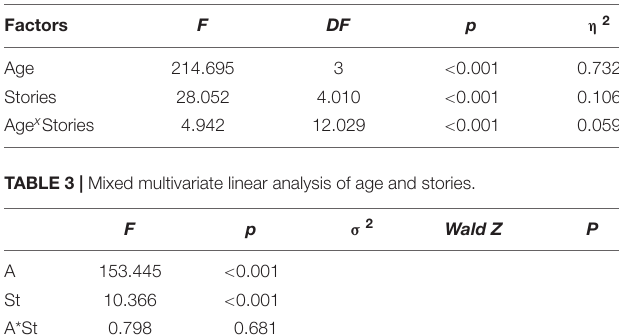
TABLE 2 | Multivariate linear analysis: age and stories.